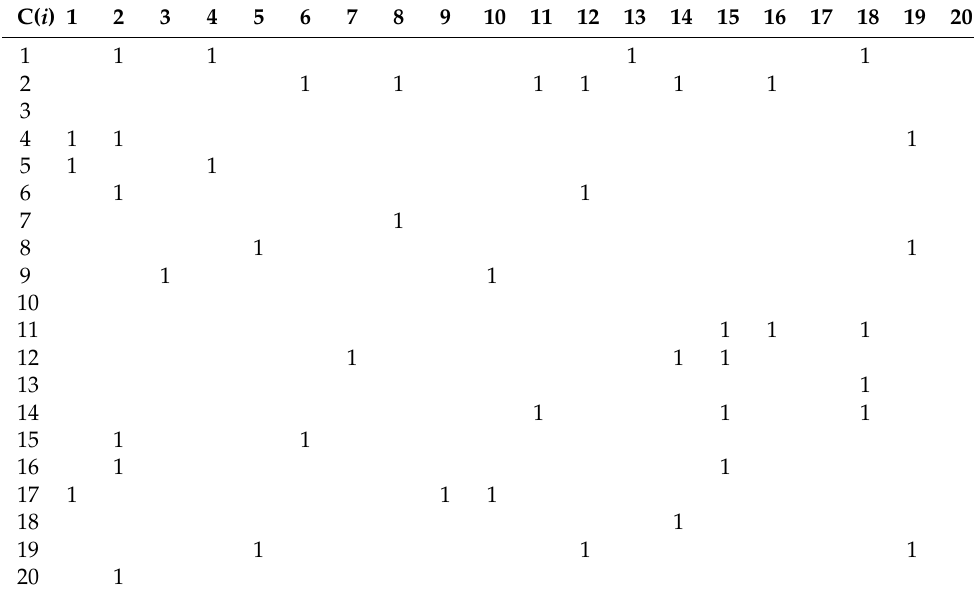
Table 4. Pairwise comparison for the interrelationship between each